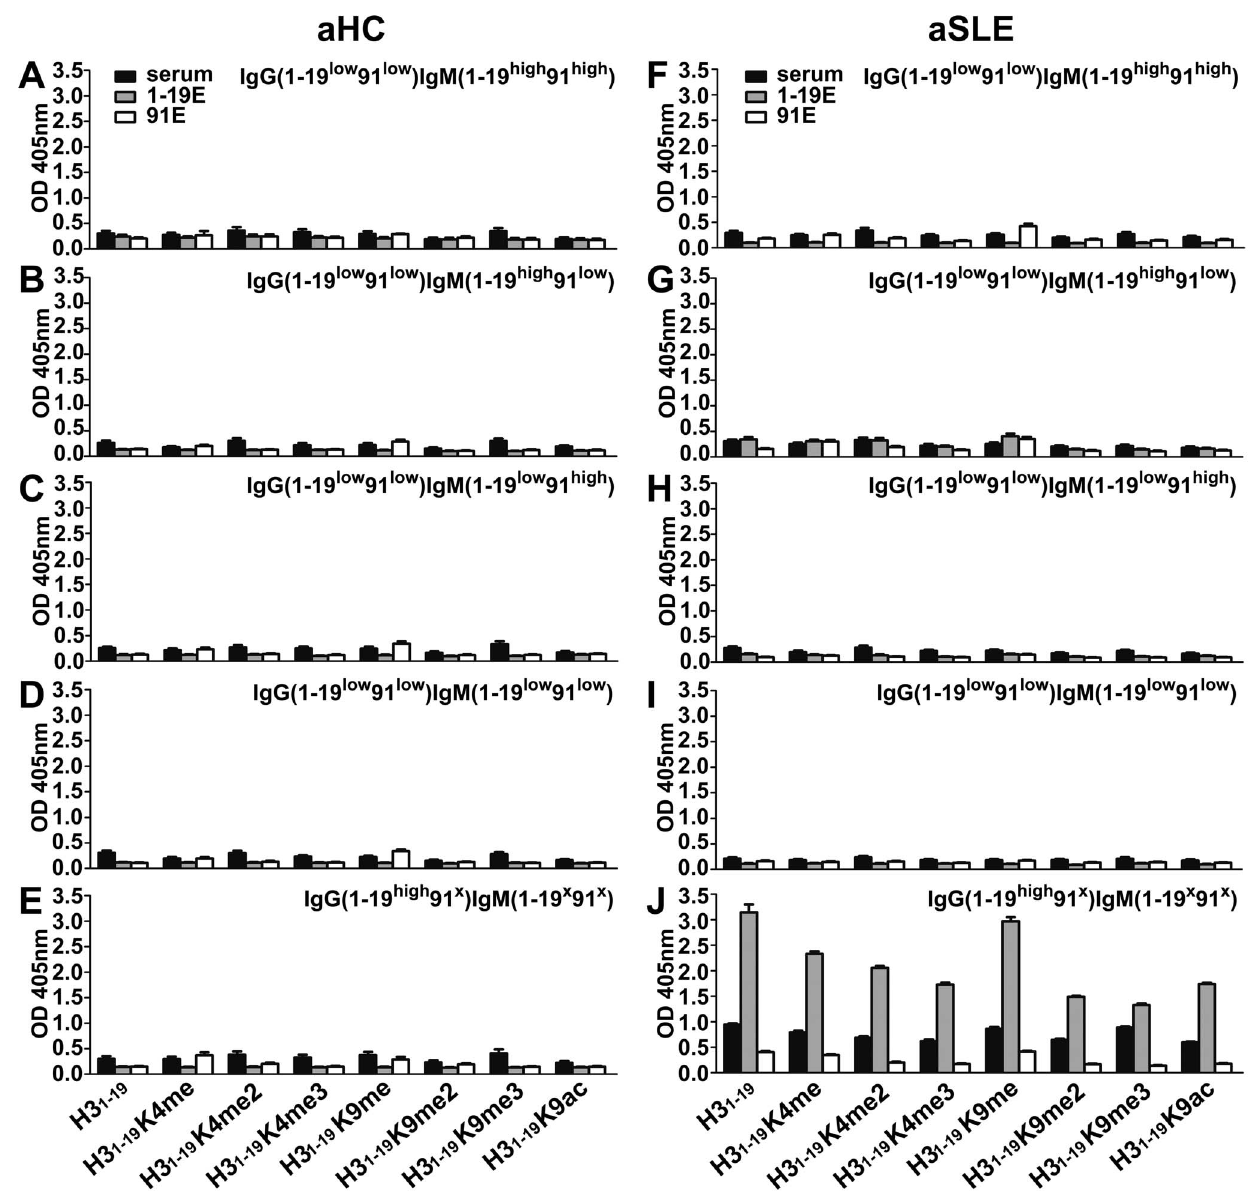
Figure 4. Reactivity of purified IgG against H3 peptides. Equal volumes (1.5 ml) of the pooled serum samples from each subgroup were affinity purified using H3 1–19 and H3 1–19 K9me beads in tandem (see Materials and Methods). Microtiter plates were coated with various peptides conjugated to BSA as indicated. Eluates from the H3 1–19 and H3 1–19 K9me beads were separately tested for their reactivity against the peptides. KT47 anti-human IgG was used as the primary Ab and HRP-conjugated goat anti-mouse IgG was used as the secondary Ab. The samples were tested in duplicate. 1–19E, Abs eluted from the H3 1–19 beads; 91E, Abs eluted from the H3 1–19 K9me beads. Data are expressed as mean + SEM. The results are representative of two independent